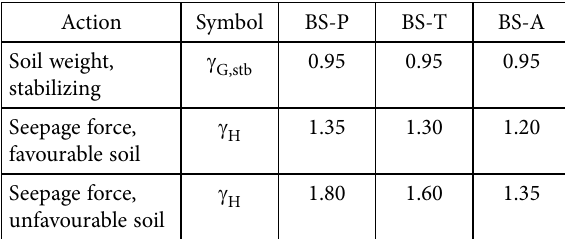
Table 1. Partial factors of safety according to DIN 1054